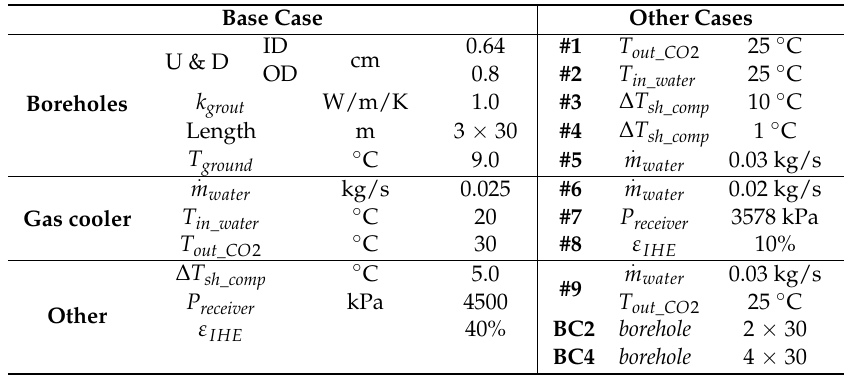
Table 6. Different cases for parametric analysis.